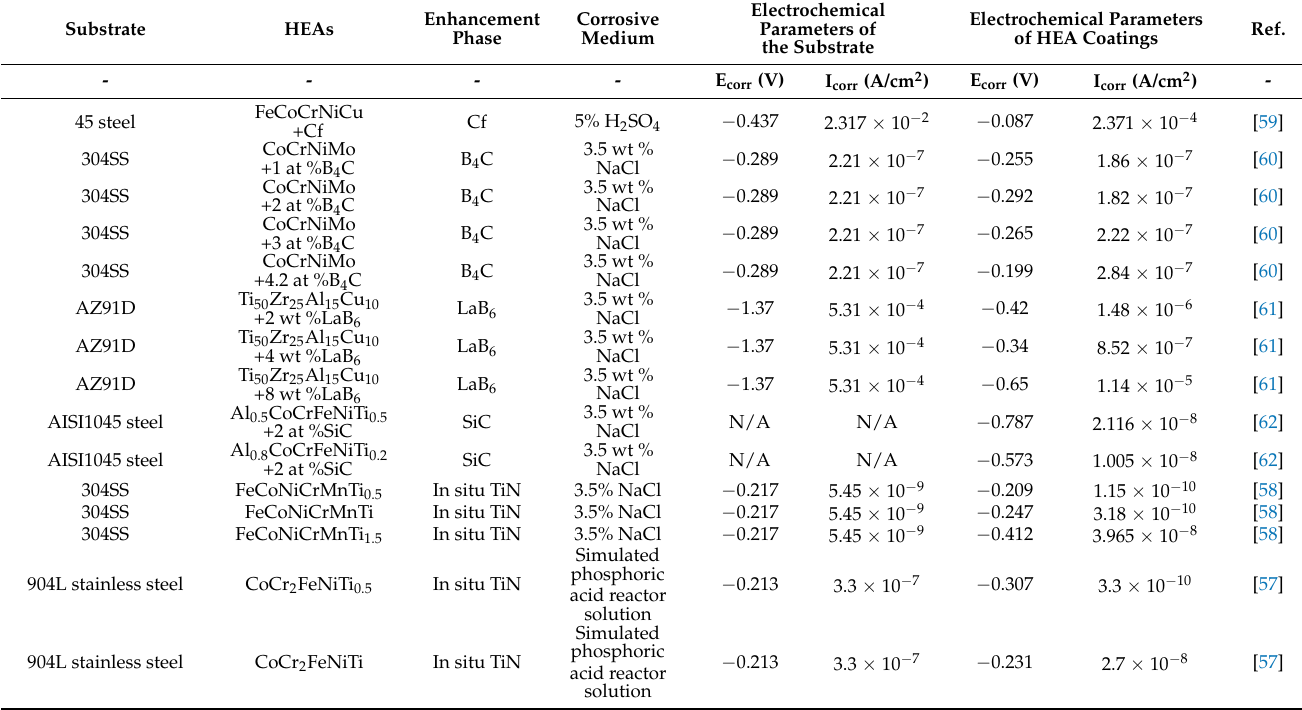
Table 3. Effect of enhanced relative LC-HEACs’ corrosion